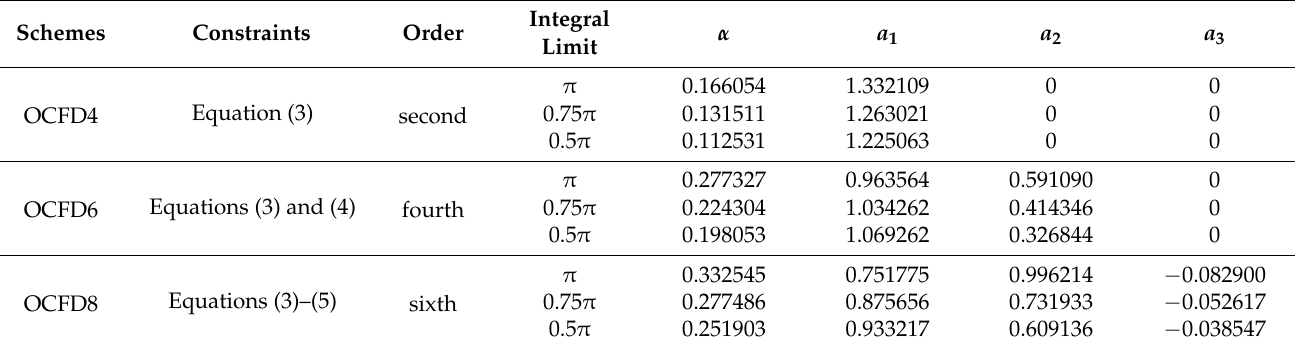
Table 2. Coefficients of the tridiagonal compact optimization